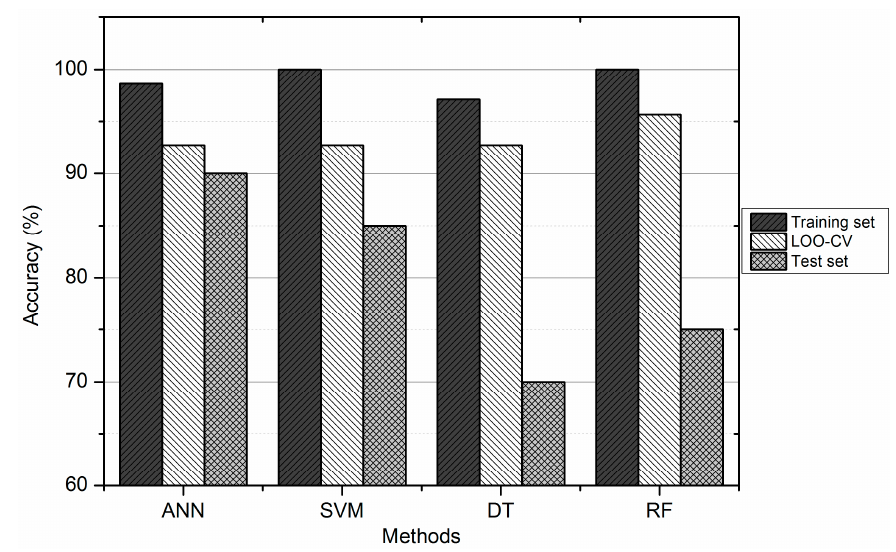
Figure 3. Correct Classification Rate (CCR) of SVM, ANN, DT, and RF.